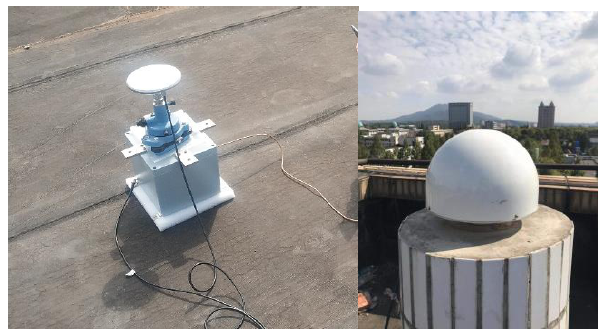
Figure 10. Experimental environment and equipment placement. Table 1. Device and data information.